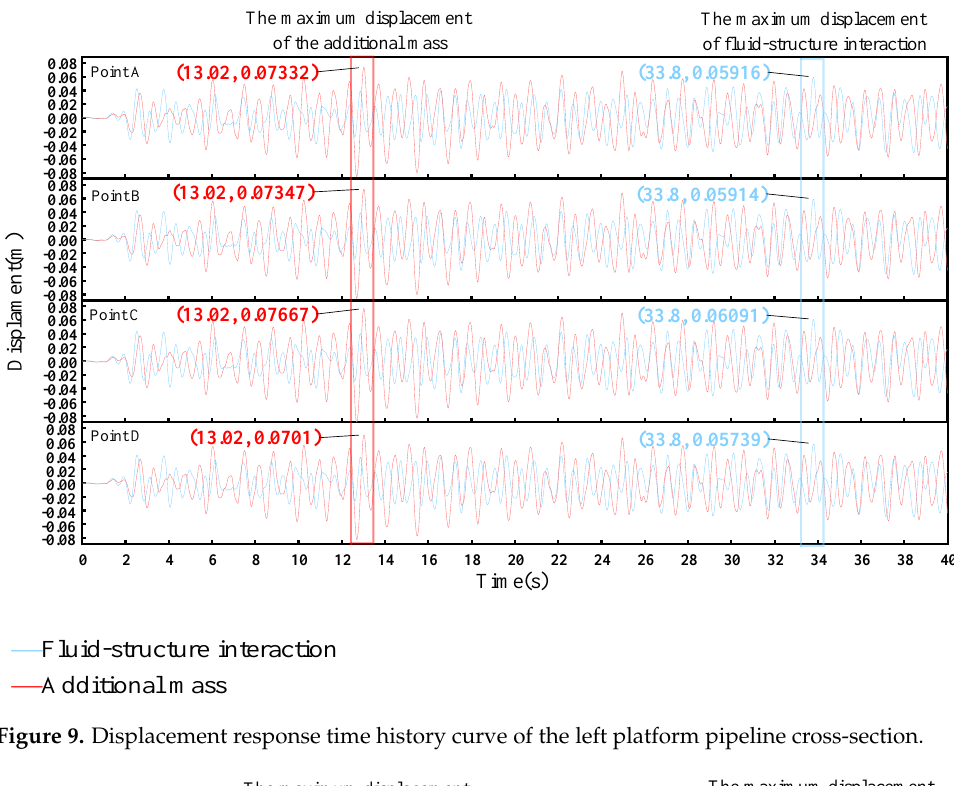
Figure 9. Displacement response time history curve of the left platform pipeline cross-section.